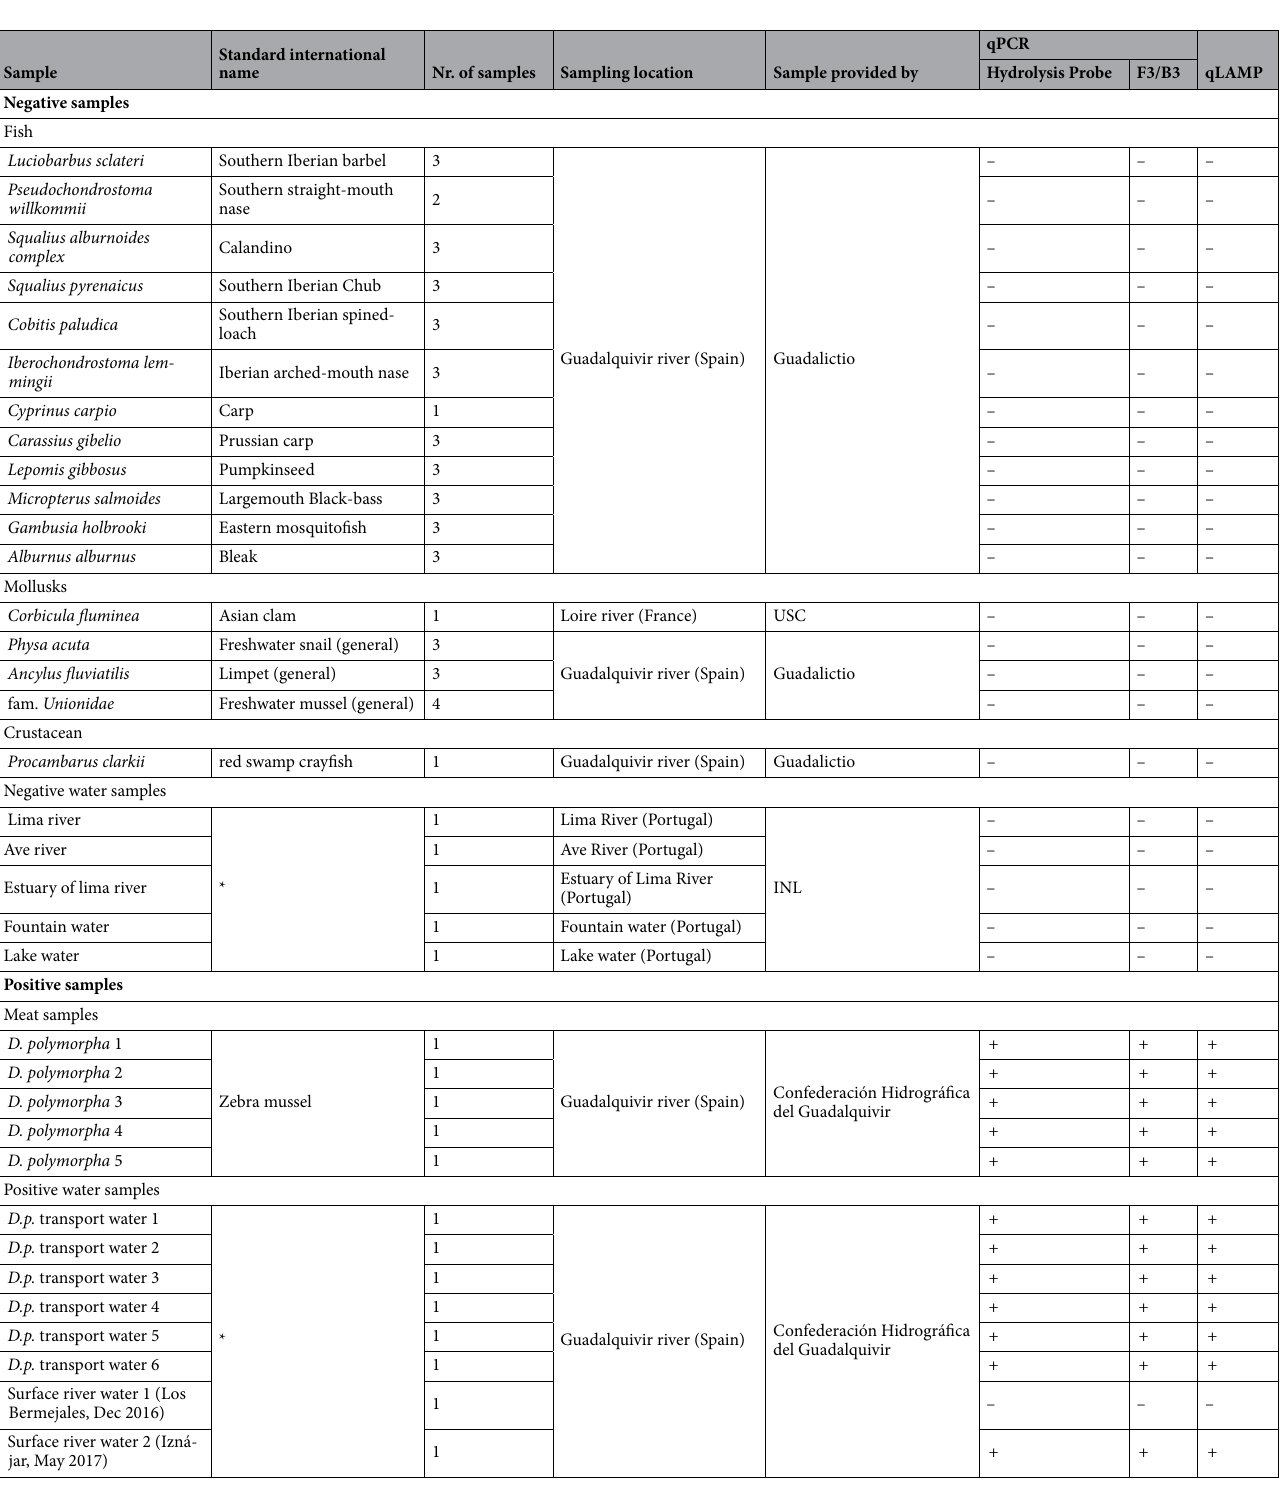
Table 1. List of all samples analyzed for the specificity evaluation of both qPCR and qLAMP methods. *Water samples with natural